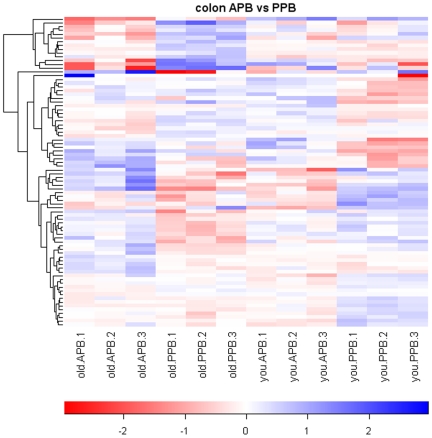
Heatmap of animal-protein based diet (APB) vs. plant-protein based diet (PPB) pairwise comparisons.Values are the GCRMA-processed probe set value (Log2 scale) minus the mean value for that probe set across all arrays. The dendrogram was created by hierarchical cluster analysis.